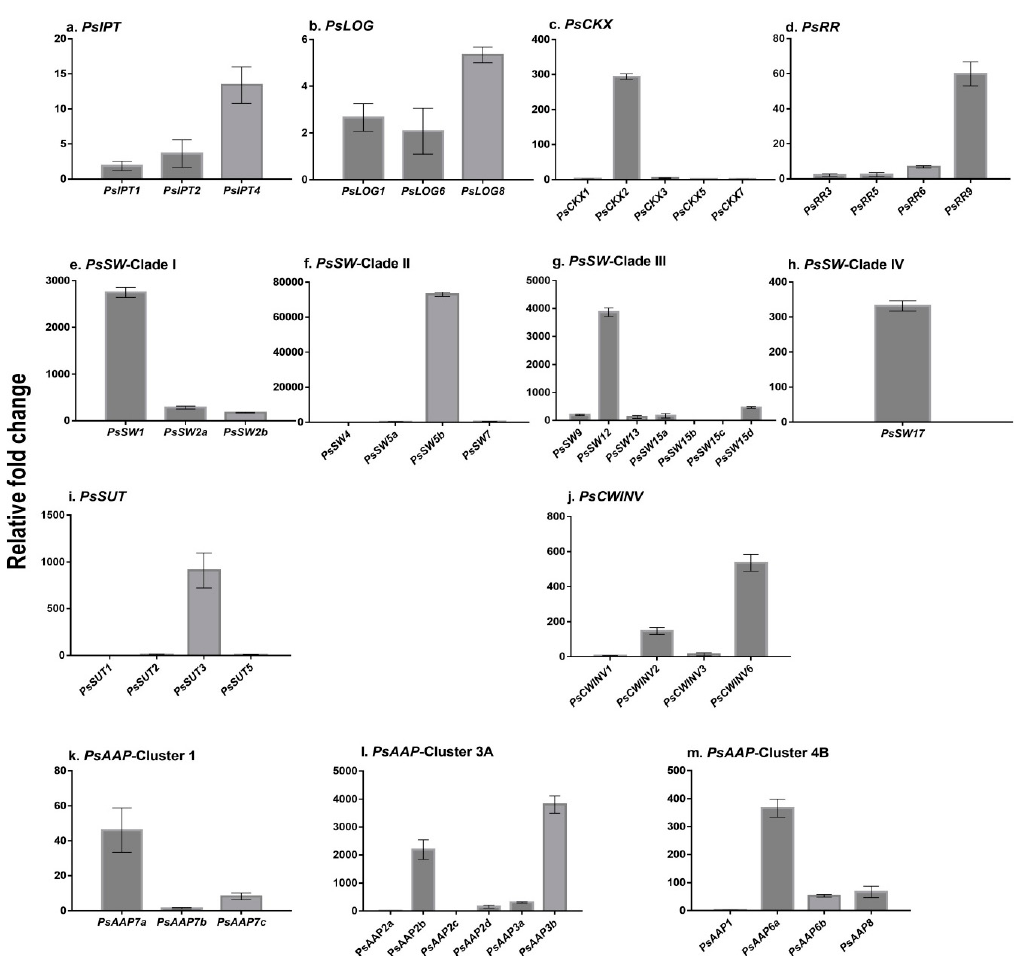
Figure 1. Relative expression of cytokinin biosynthesis ( PsIPT ), activation ( PsLOG ), degradation ( PsCKX ) and response regulator ( PsRR ) gene family members along with PsSWEET ( PsSW ), PsSUT , Fold-change values were calculated using PsEF , U18S , PsGAP and PsACT as internal controls using three technical replicates for each of two biological replicates in the RT-qPCR. The results are expressed as ±